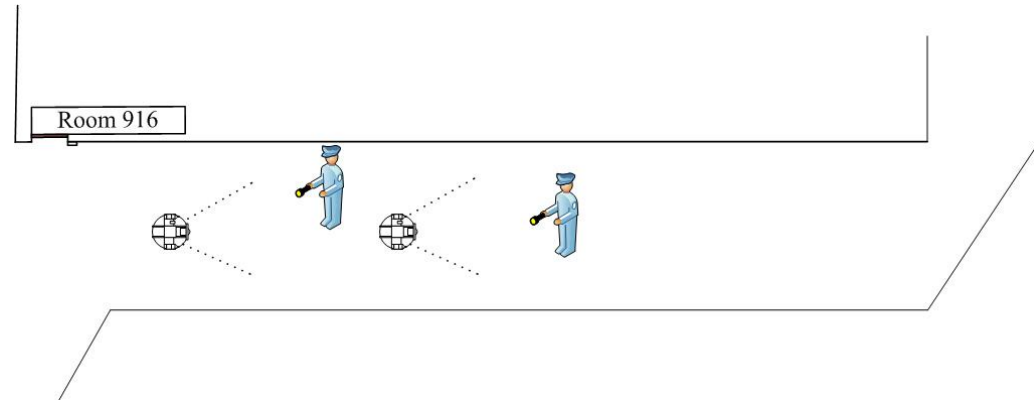
Figure 30. Security guards inspect the scene directly.